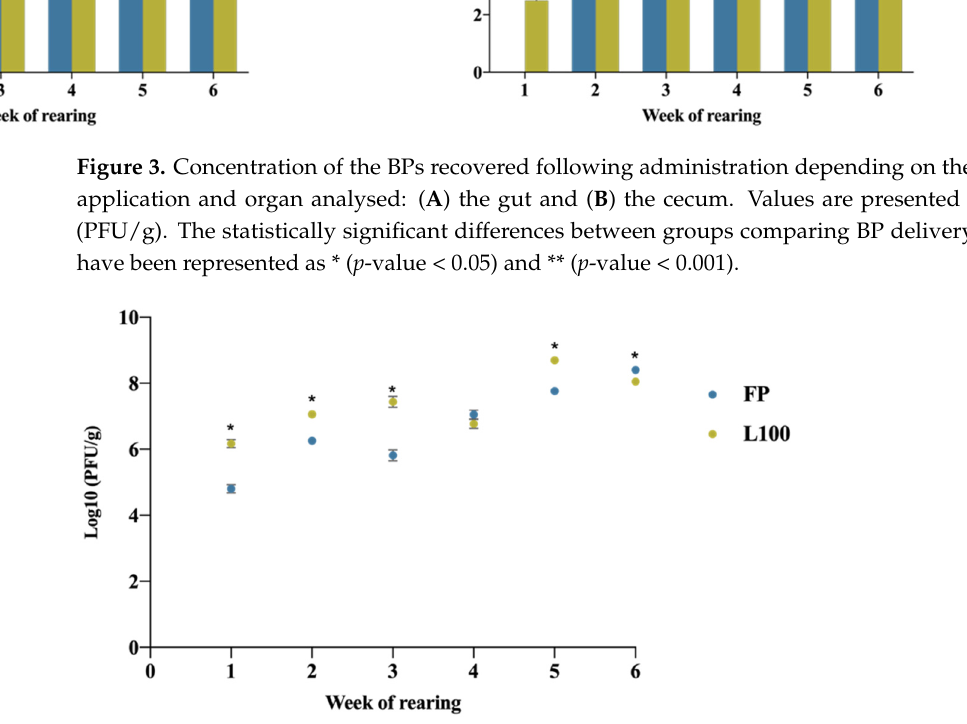
Figure 3. Concentration of the BPs recovered following administration depending on the week of application and organ analysed: ( A ) the gut and ( B ) the cecum. Values are presented as Log10 (PFU/g). The statistically significant differences between groups comparing BP delivery method have been represented as * ( p -value < 0.05) and ** ( p -value < 0.001).